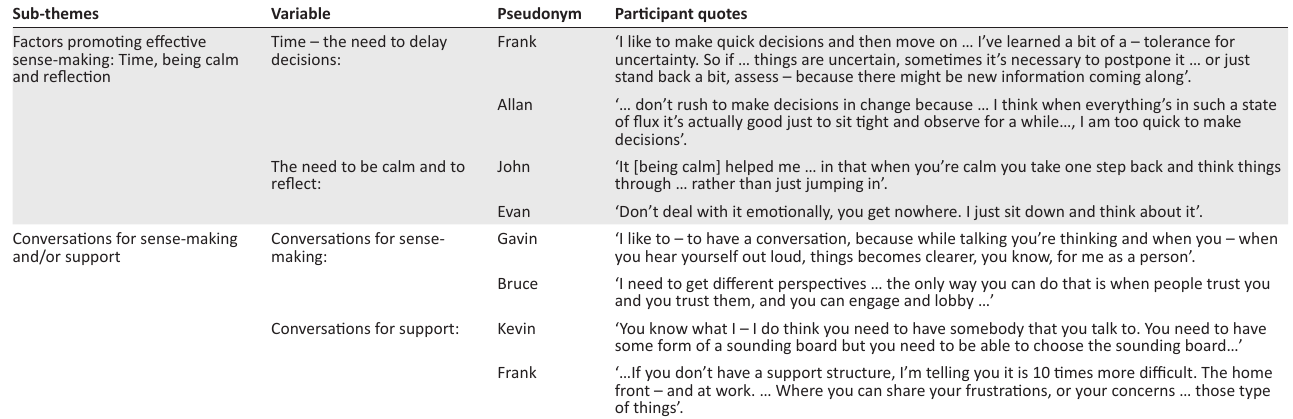
TABLE 4: The value of effective sense-making.